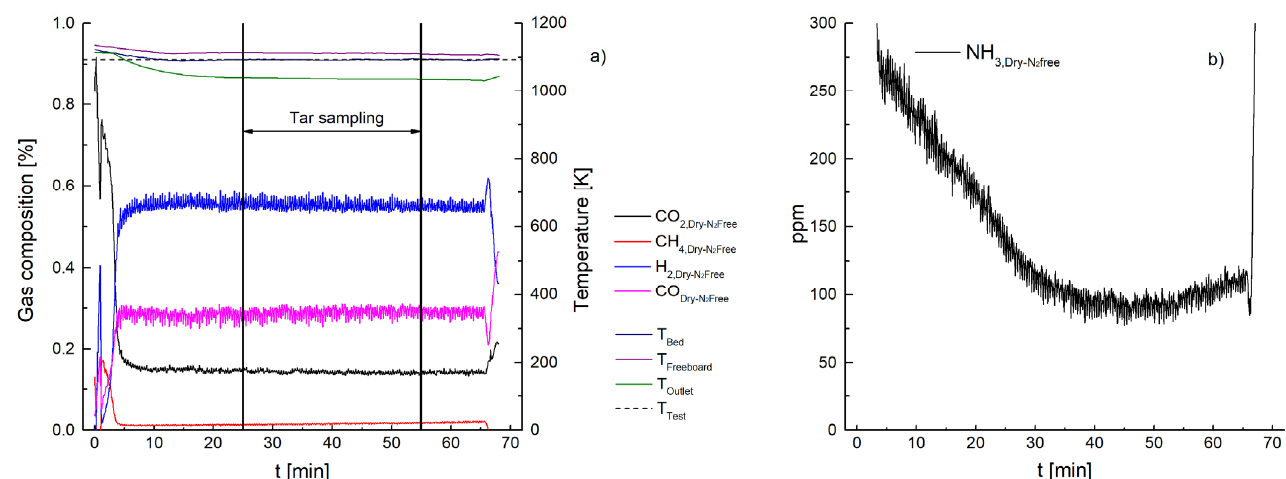
Figure A6. Temperature and gas composition ( a ) and ammonia content ( b ) during test 7 .